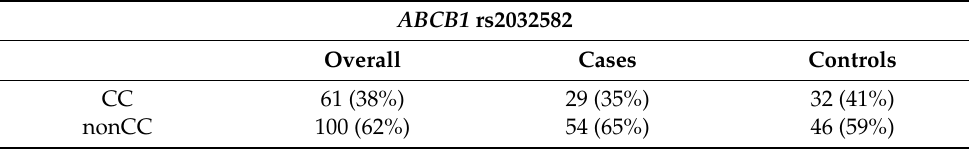
Table A2. Numbers of CRC cases and healthy controls depending on ABCB1 gene polymorphism